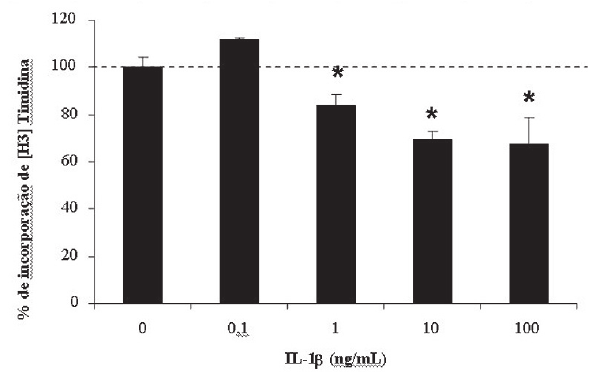
Fig. 1 - Curva dose-resposta da incorporação de [ 3 H] timidina no DNA de células primárias de músculo liso de safena humana tratadas com Interleucina - 1ß. As células foram incubadas por 3dias com 0,5% de BSA para sincronização do ciclo celular, seguido de 48 horas de estímulo na presença de 10% de soro fetal bovino. A [ 3 H] timidina (10 µ Ci/mL) foi adicionada nas últimas 24 horas. Cada barra representa média ± desvio padrão de 6 experimentos em triplicata. Os dados foram normatizados em relação à incorporação de [ 3 H] timidina das células sem tratamento (linha tracejada) - (* indica p < 0,05)